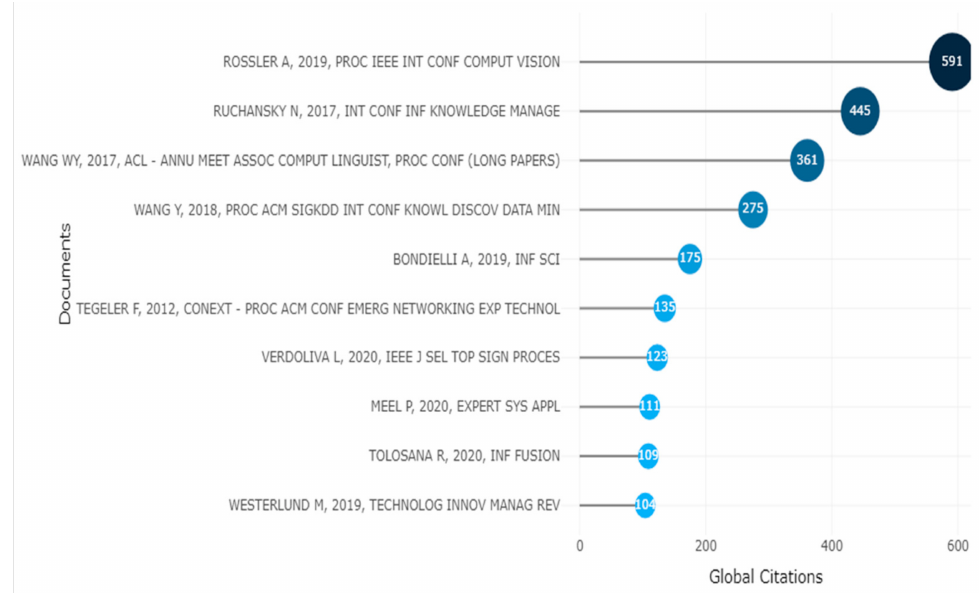
Figure 13. Global citations.